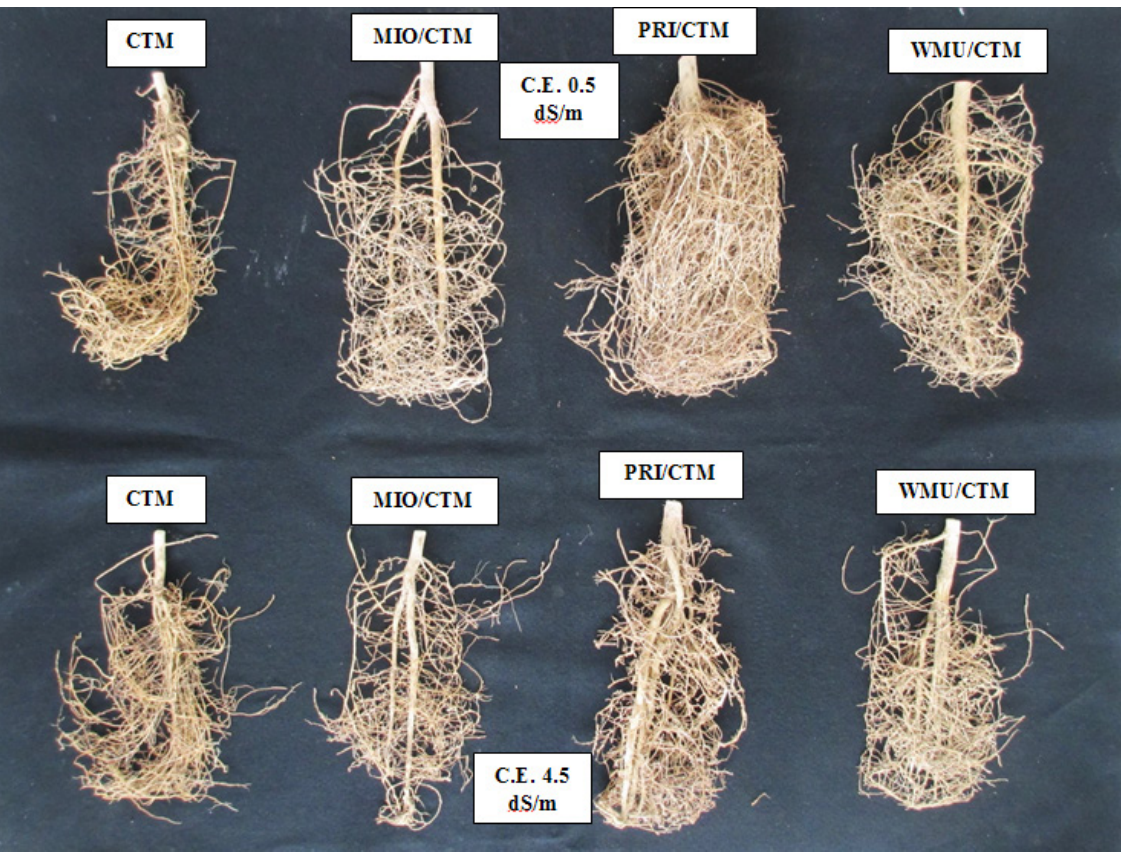
Figure 4. Effects of salt stress on roots for each scion/rootstock combination at 90 days.